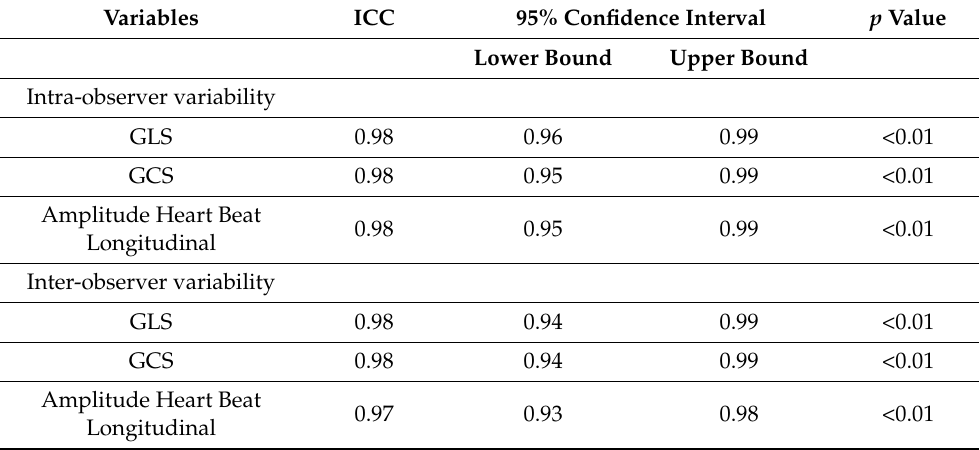
Table 7. Intra-and inter-observer variability of GLS, GCS and amplitude heart beat longitudinal HDFs.